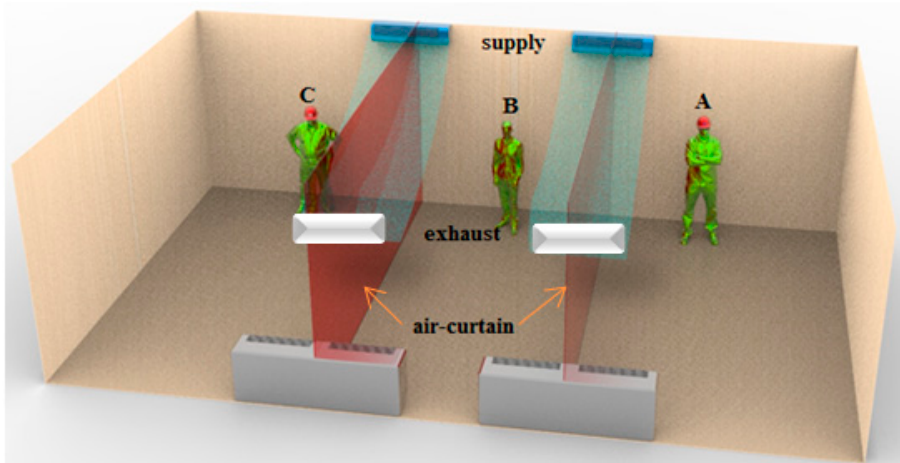
Figure 2. Diagrams of the ventilation air flow patterns in the room with the inlet and outlet registers on the side walls (Case 2); the mannequins are in the same position as in Figure 1. It is known that the respiratory droplet emitted by one person infected with the COVID-19 virus in an indoor environment causes the contamination of other people in that space. Figure 1 shows a large 10 m × 6 m × 3 m (L × W × H) room that is considered in this study. The ventilation air flow along the length of the indoor space and the 0.5 m 2 ventilation supply and exhaust registers are also shown in the figure. The height of the mouth/nose through which air is inhaled or exhaled is 1.65